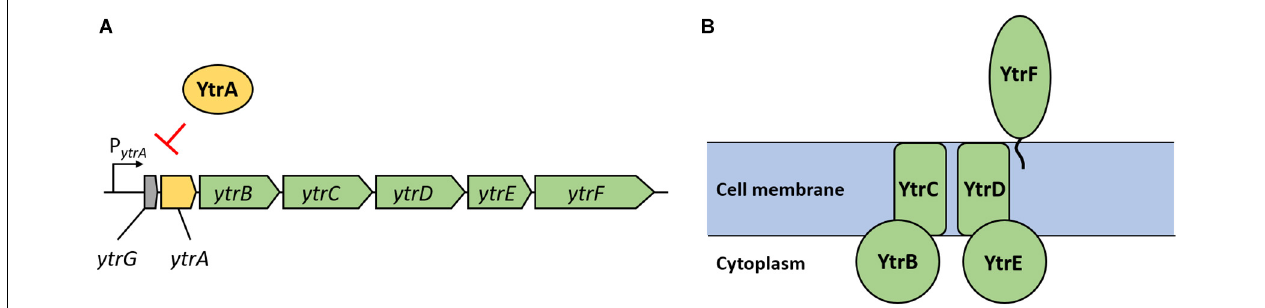
FIGURE 2 | Genetic organization of the ytrGABCDEF operon and organization of the putative ABC transporter YtrBCDEF. (A) Reading frames are depicted as arrows with respective gene names. Green arrows indicate genes encoding proteins suggested to form the ABC transporter; the yellow arrow indicates the gene coding for the repressor YtrA and the gray arrow indicates the small open reading frame called ytrG . The map is based on information provided in Salzberg et al. (2011). (B) Organization of the putative ABC transporter YtrBCDEF as suggested by Yoshida et al. (2000). YtrB and YtrE are nucleotide binding proteins, YtrC and YtrD membrane spanning proteins and YtrF is a substrate binding protein. The role and localization of the YtrG peptide remain